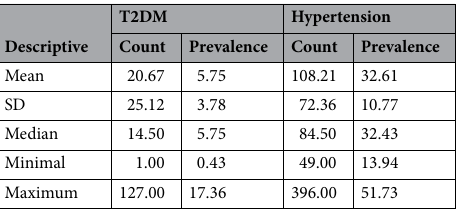
Table 2. Descriptive count and prevalence rate of T2DM and hypertension (per 100,000 people) for the 2017 to 2018 period in South Sulawesi Province, Indonesia.